Question: What form of chart is displayed?
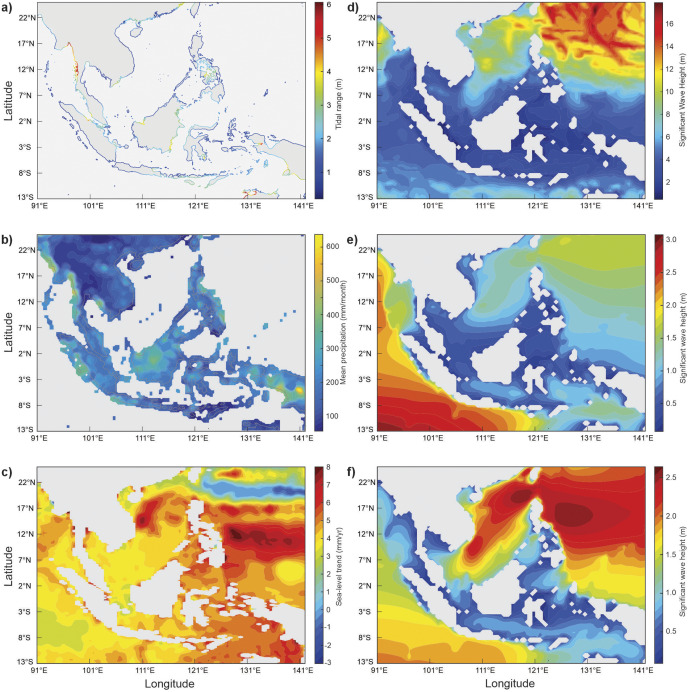
Answer: line